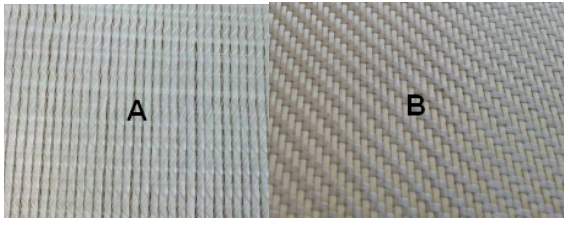
Figure 12. UD vs. plain weave